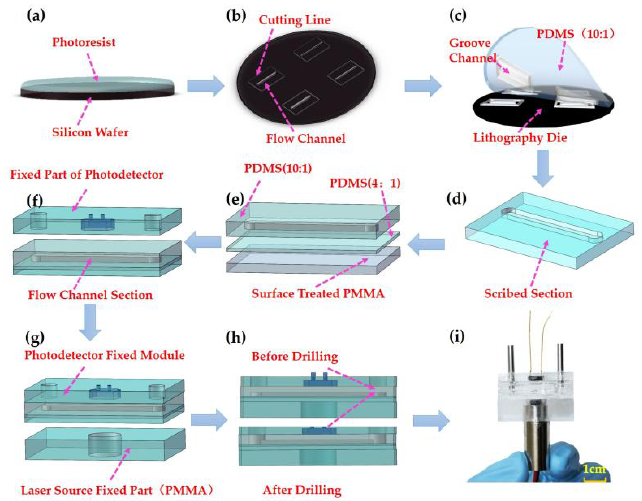
Figure 3. The fabrication process of the device. ( a ) Coating on the wafer. ( b ) Graphic mold after exposure and development process. ( c ) Using polydimethylsiloxane (PDMS) to mold the flow channel. ( d ) Dicing a complete model according to the designed line frames. ( e ) Bonding the flow channel with PDMS at the ratio of 4:1, using the polymethyl methacrylate (PMMA) to increase the stability of the device. ( f , g ) Bonding the flow channel with detector and light source module designed previously. ( h ) Punching to get through the flow channel. ( i ) Photograph after the integrated design.